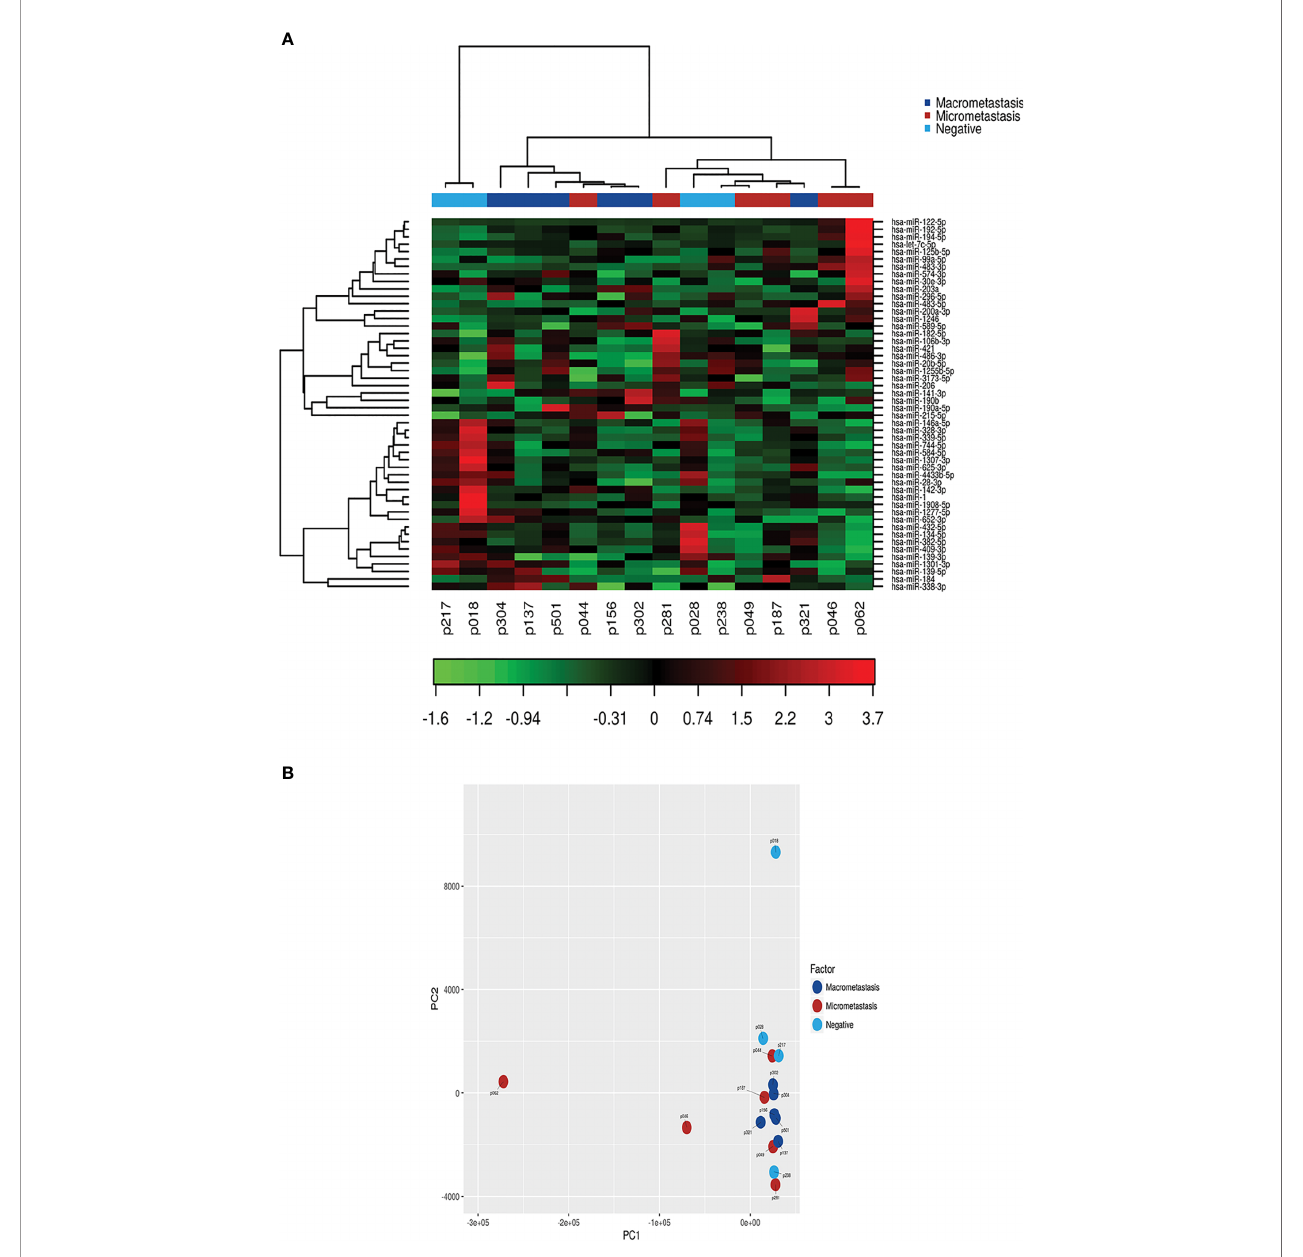
FIGURE 2 | Class discovery associated with the SLN metastatic status. The analysis was performed using the 50 miRNAs with the largest coef fi cient of variation based on trimmed mean of M-values (TMM counts). (A) Heat map and unsupervised hierarchical clustering. Each row represents one miRNA and each column represents one sample. The color represents the relative expression level of a miRNA across all samples. The color scale shows the expression level above (red) or below (green) the mean. (B) Principal Component Analysis (PCA) of samples according to the SLN metastatic status of